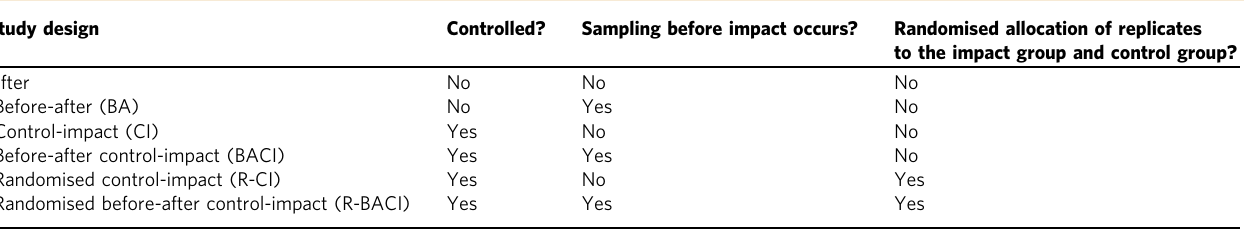
Table 3 De fi nitions used to categorise studies based on the study design they